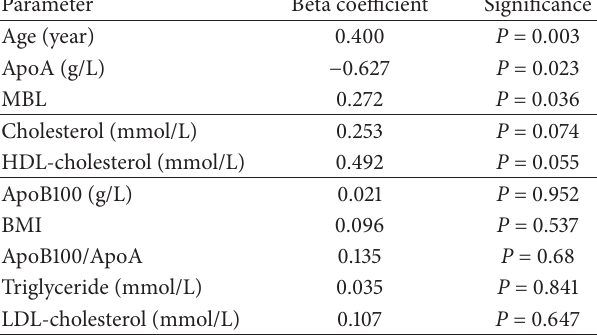
Table 2: Results of backward stepwise multiple regression analysis with beta coefficient and significance. Age, ApoA, and MBL were significantly associated with carotid intima-media thickness. Parameter Beta coefficient Significance